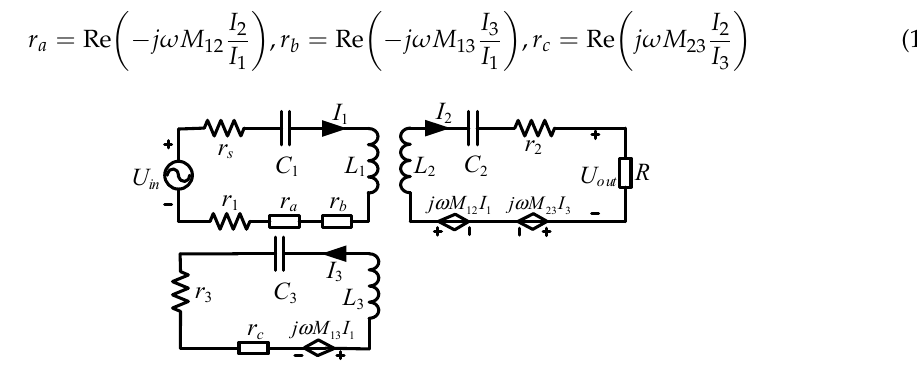
Figure 3. Decoupled circuit of resonant tank for the proposed 3-coil system.